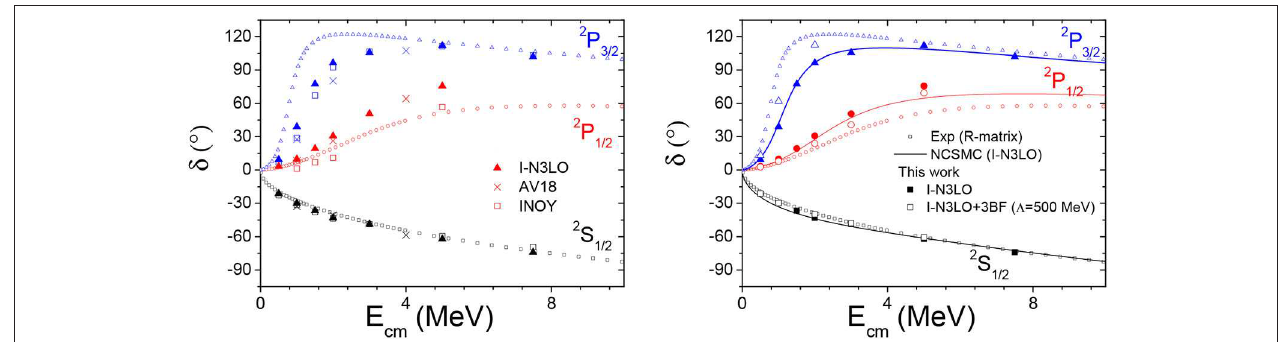
FIGURE 9 | Comparison between the theoretical predictions of the n- 4 He, S- and P-waves, phaseshifts, and the results of a partial wave analysis of the experimental data by Hale [94]. In the left panel, the results corresponding to different NN interactions are indicated respectively by triangles (I-N3LO), × (AV18), or squares (INOY), and the dotted curves correspond to R-matrix analysis. In the right panel, our calculated values for the I-N3LO model—with (empty symbols) and without (full symbols) three-body forces (3BF)—are also compared with the results obtained by NCSMC calculations (solid lines) of Navrátil et al. [37].